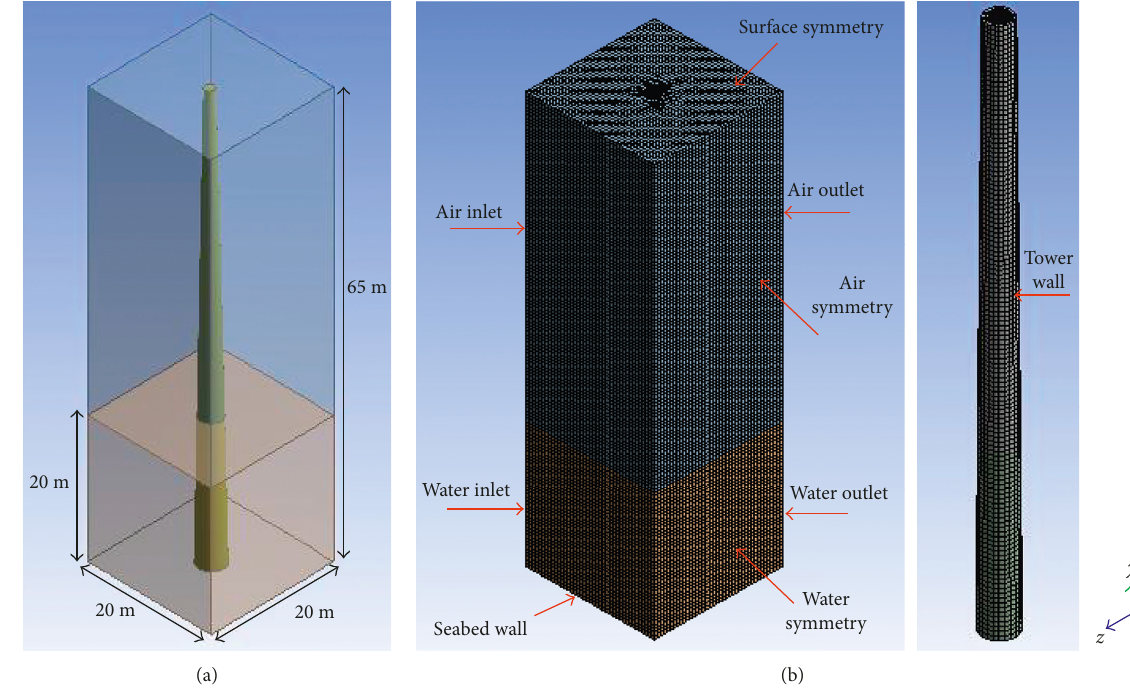
Figure 6: (a) Unmeshed domains. (b) Meshed domains.